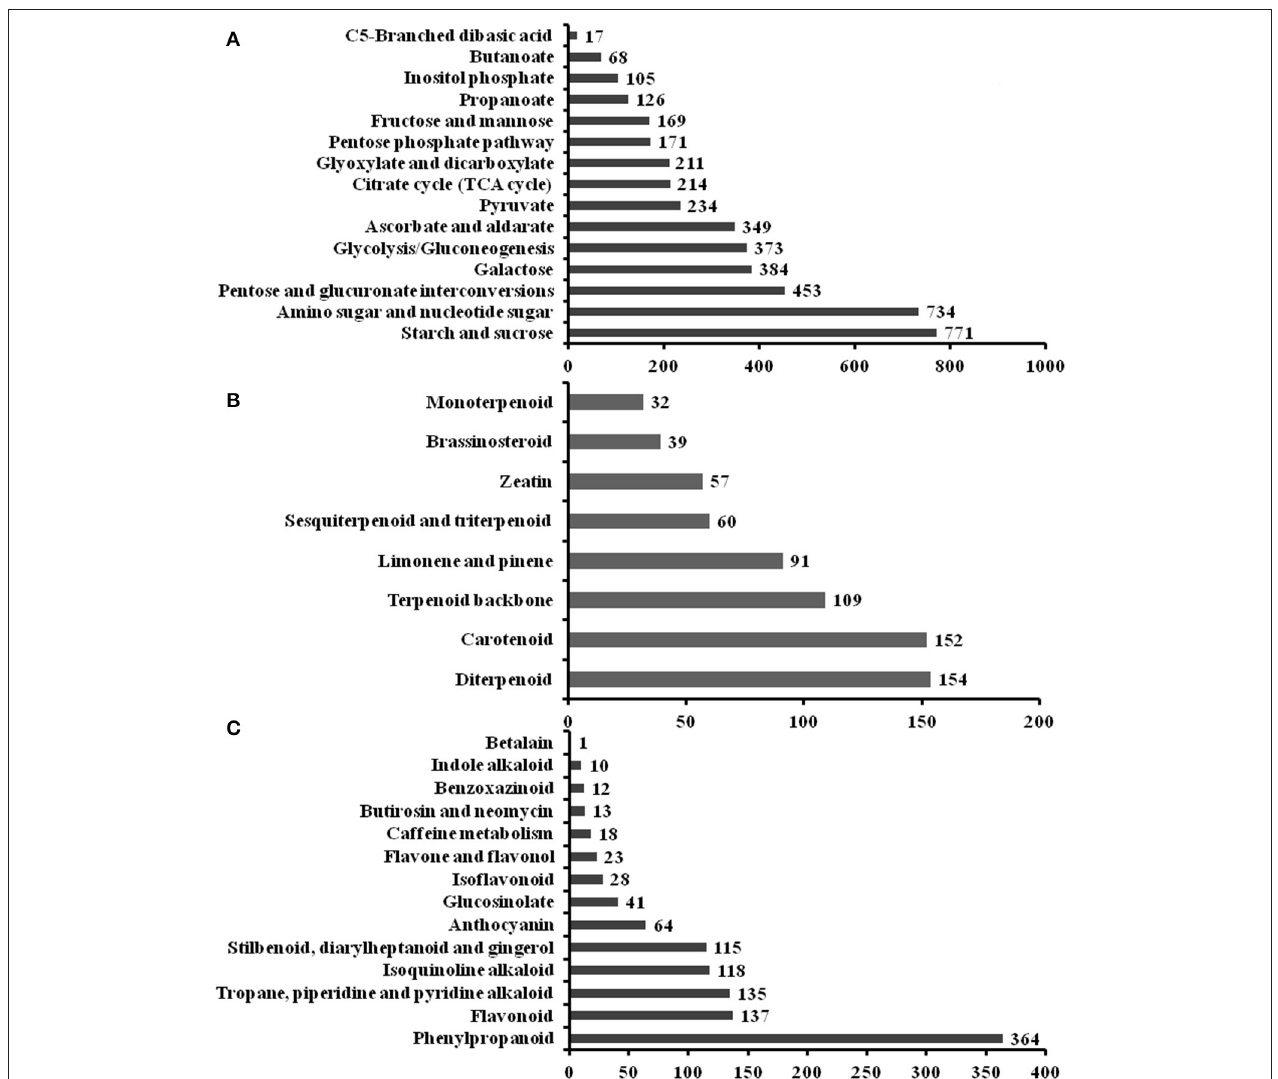
FIGURE 2 | Summary of the Kyoto Encyclopedia of Genes and Genomes (KEGG) annotation of unigenes in sub-pathways of metabolism in T. hemsleyanum FD-TRs. (A) Carbohydrate metabolism, (B) metabolism of terpenoids and polyketides, and (C) biosynthesis of other secondary